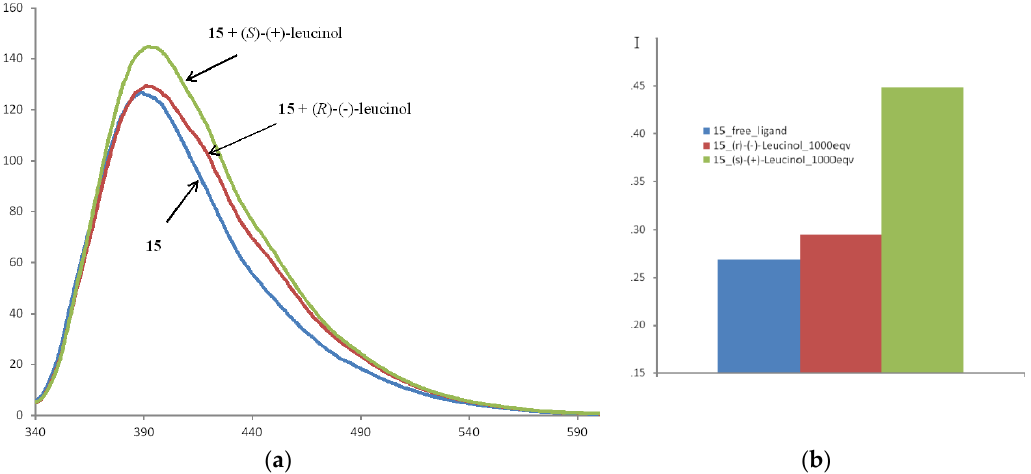
Figure 4. Fluorescence spectra of Compound 15 in the presence of ( R )- and ( S )-enantiomers of leucinol (1000 equiv.); ( a ) general view; ( b ) schematic representation of the changes in emission. Changing the dansyl fluorophore groups for 7-methoxycoumarin substituents (compound 15 ) resulted in the absorption at 320 nm and the emission maximum shifted to the shortwave region at 390 nm (Figure 4). The addition of ( S )-leucinol slightly increased the fluorescence intensity while ( R )-isomer did not change it at all. Like its dansylated analog 14 , 7-methoxycoumarin derivative 15 in other cases showed weak responses to the addition of other amino alcohols, e.g., the two enantiomers of 2-amino-1-propanol only slightly changed its emission intensity (Figure 5).